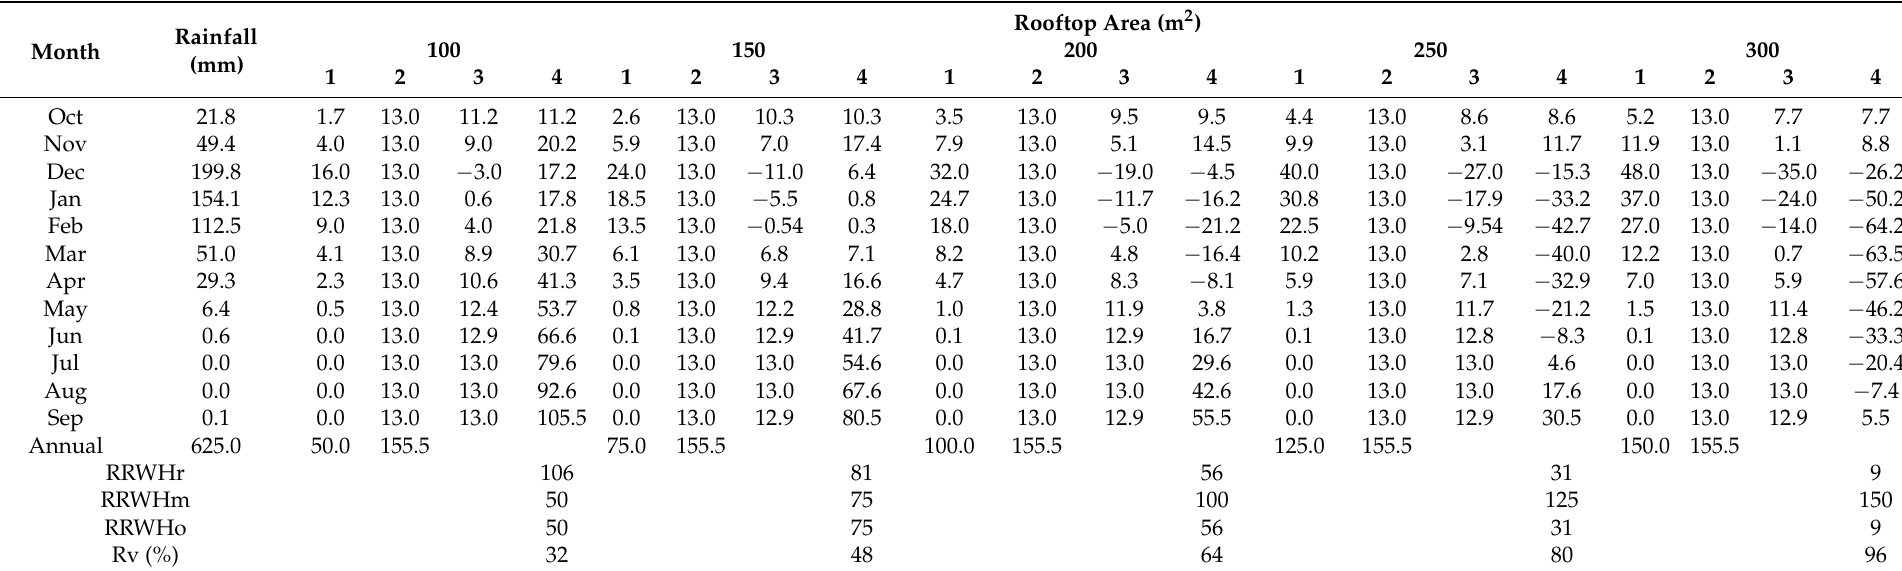
Table 3. RRWHo calculations for Nablus governorate for the different rooftop areas for the S1